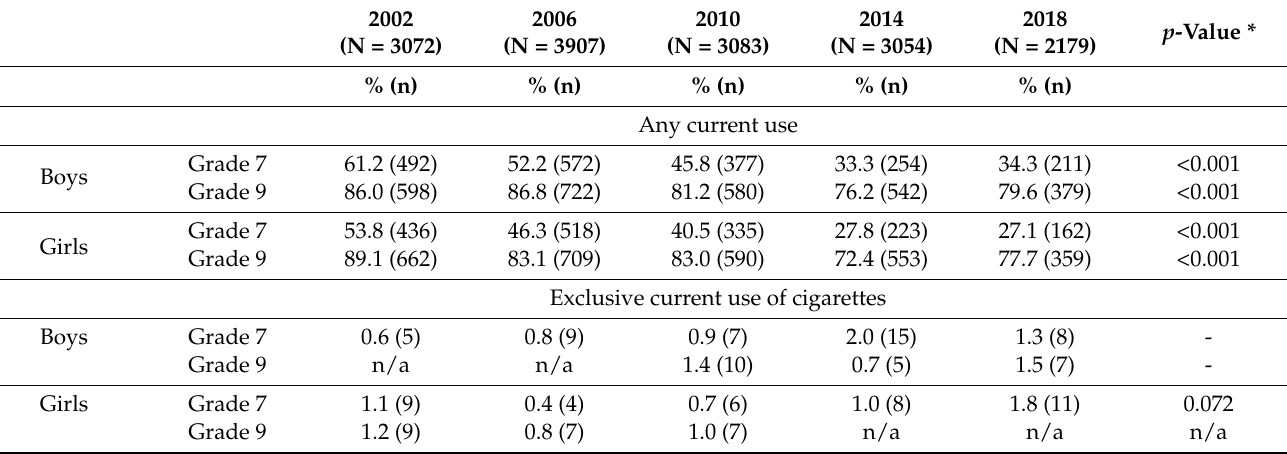
Table 5. Current substance use at five time points, 2002–2018, according to gender and age